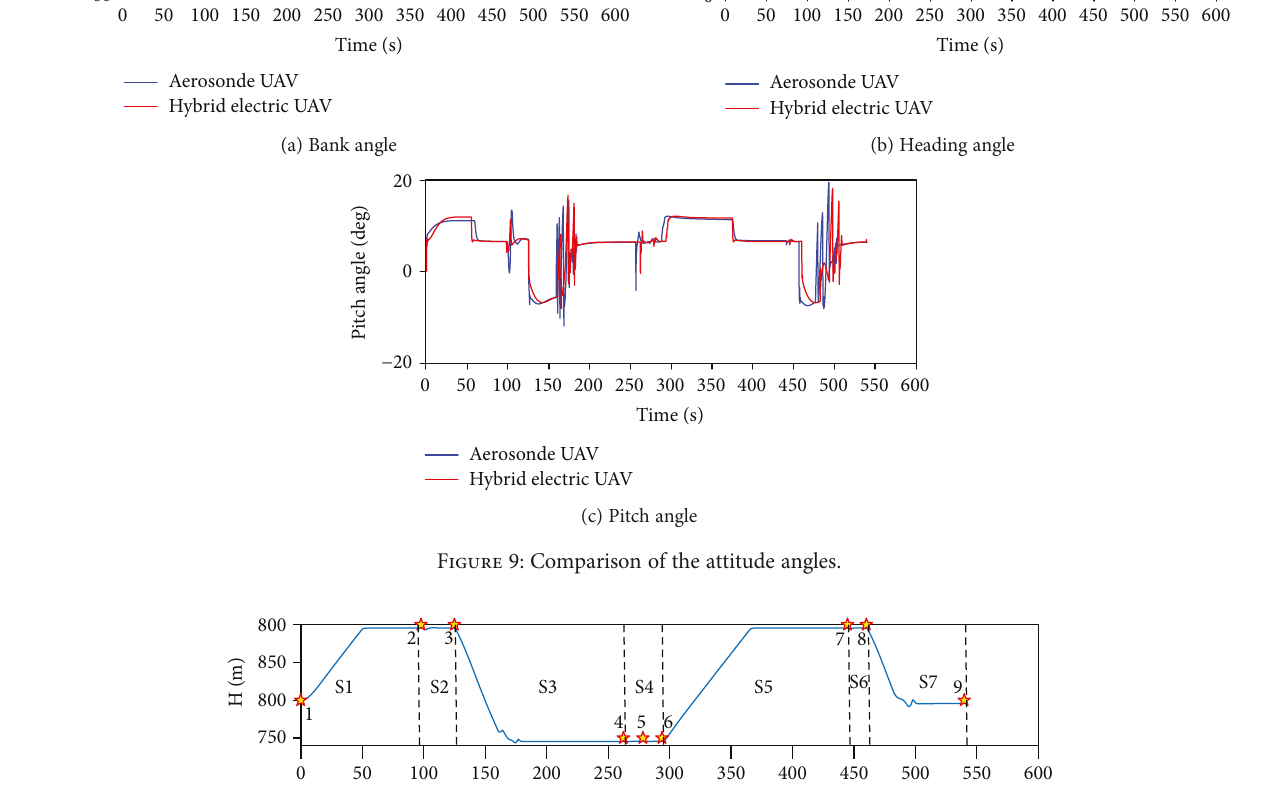
Figure 10: Height and velocity of the hybrid electric